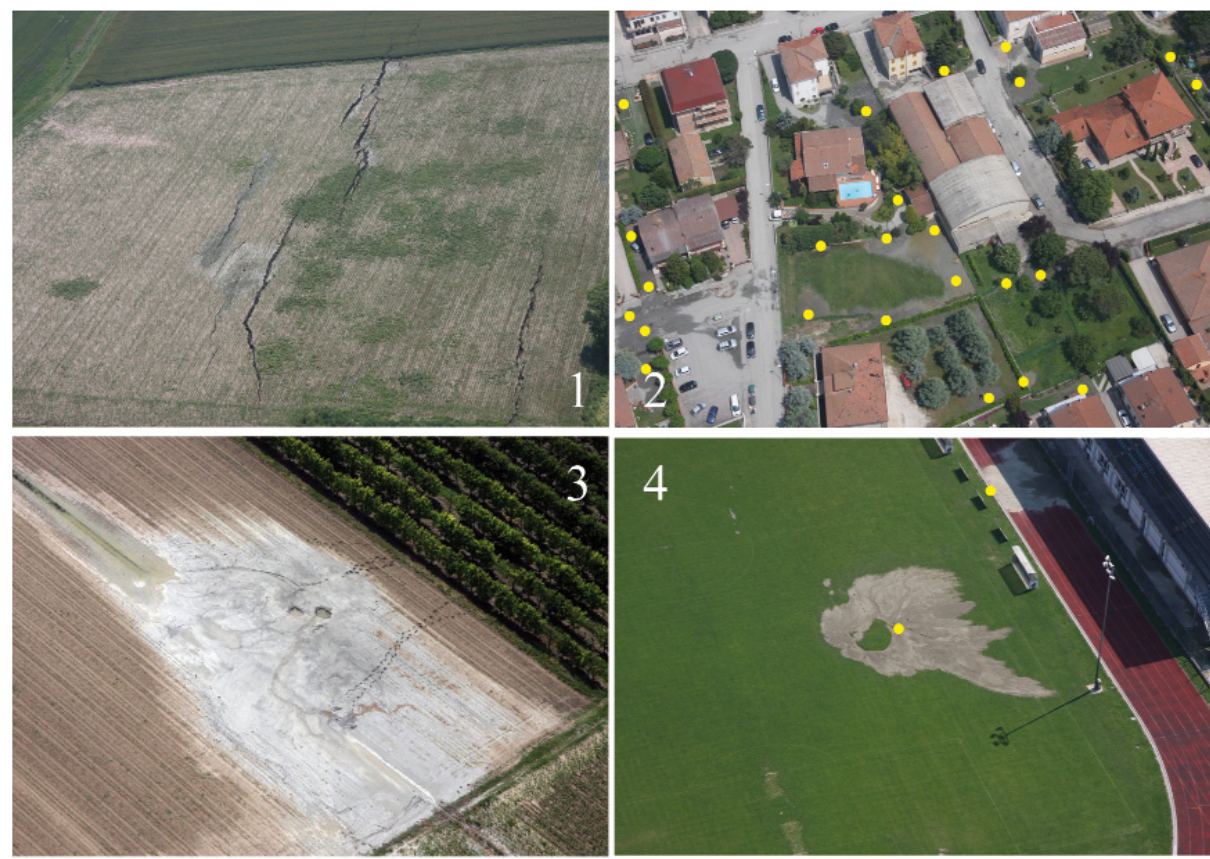
Figure 3. Some examples from the mapped surficial effects. 1) Long tension cracks (up to 1 m in width and 2 m in depth) and 'grabens' south of San Carlo (Ferrara Province); 2) Sand eruptions (yellow spots) from wells, cracks and foundations inside the town of San Carlo; 3) eruption of sand in an open field; note the formation of small craters; and 4) eruption of sand in San Felice sul Panaro football field (Modena